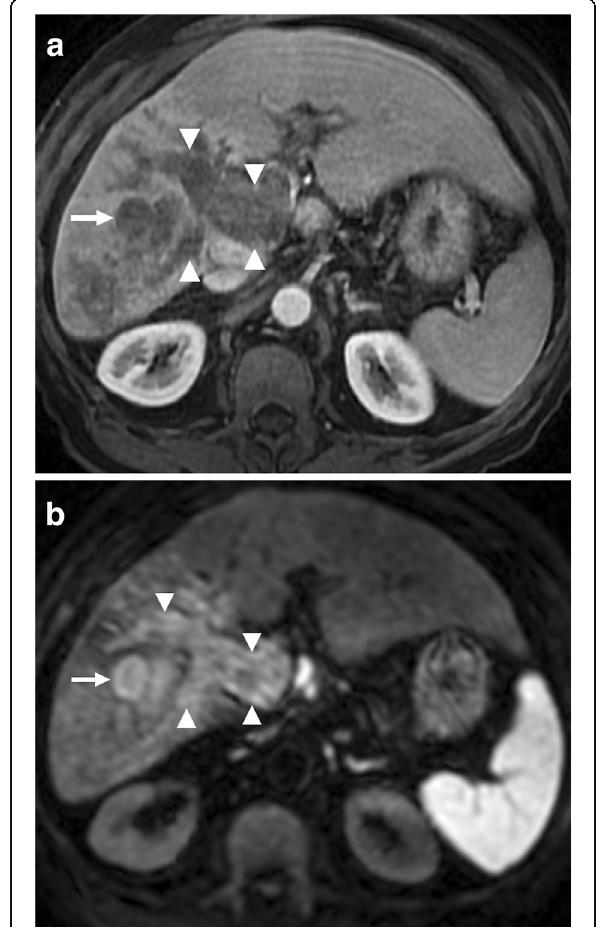
Fig. 2 A 76-year-old male with known cirrhosis presents with elevated liver enzymes and alpha fetoprotein (AFP) levels. a Axial postcontrast T1W MR image demonstrates the HCC focus within the right liver lobe (arrow) with associating tumor of the main and right portal veins (arrowhead). Note contrast enhancement within the thrombus and its expansile nature extending outside the confines of the portal vein. b DWI sequence shows high signal intensity representing diffusion restriction of both the main tumor (arrow) and its intravenous component